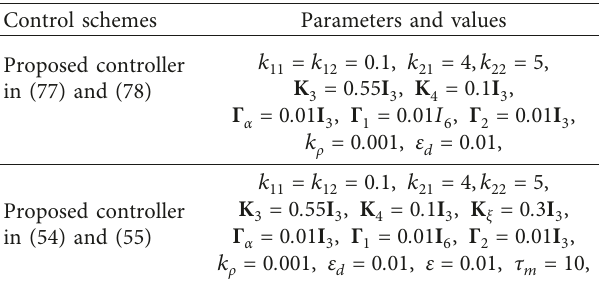
Table 2: Design parameters for the different controllers.